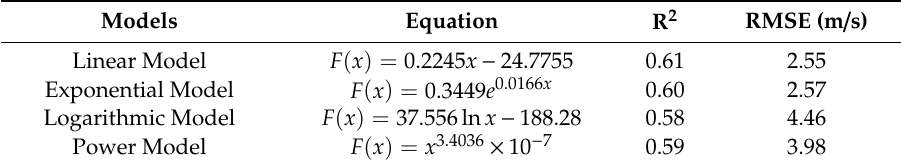
Table 2. Four regression models and their